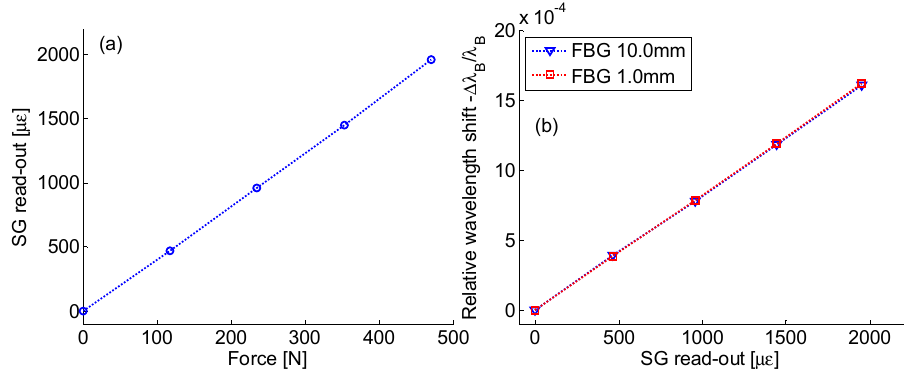
Figure 4. ( a ) Surface strain (from electrical SG) vs. applied force; and ( b ) relative wavelength shifts of FBGs vs. surface strain.